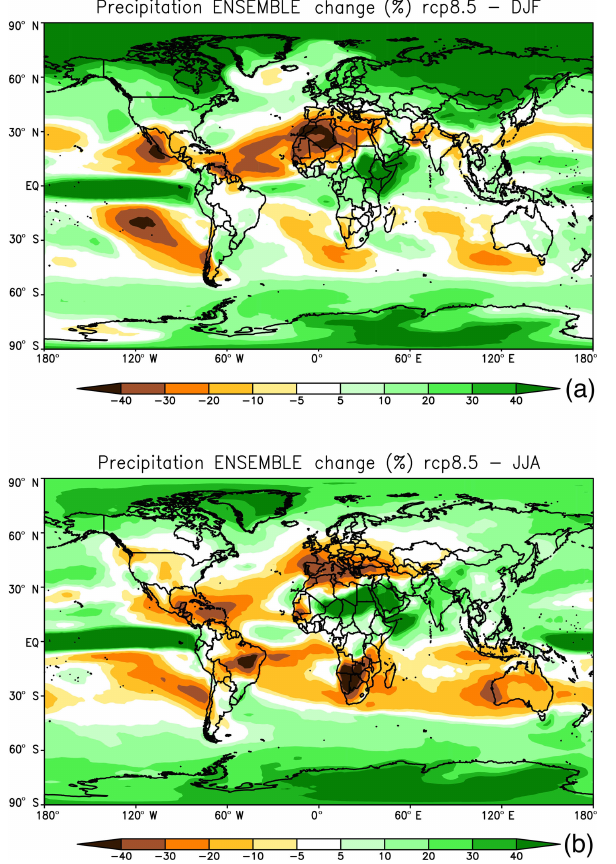
Figure 2. Ensemble mean change in precipitation (RCP8.5, 2071– 2100 minus 1981–2010) for December–January–February (a) and June–July–August (b) in the CMIP5 ensemble of